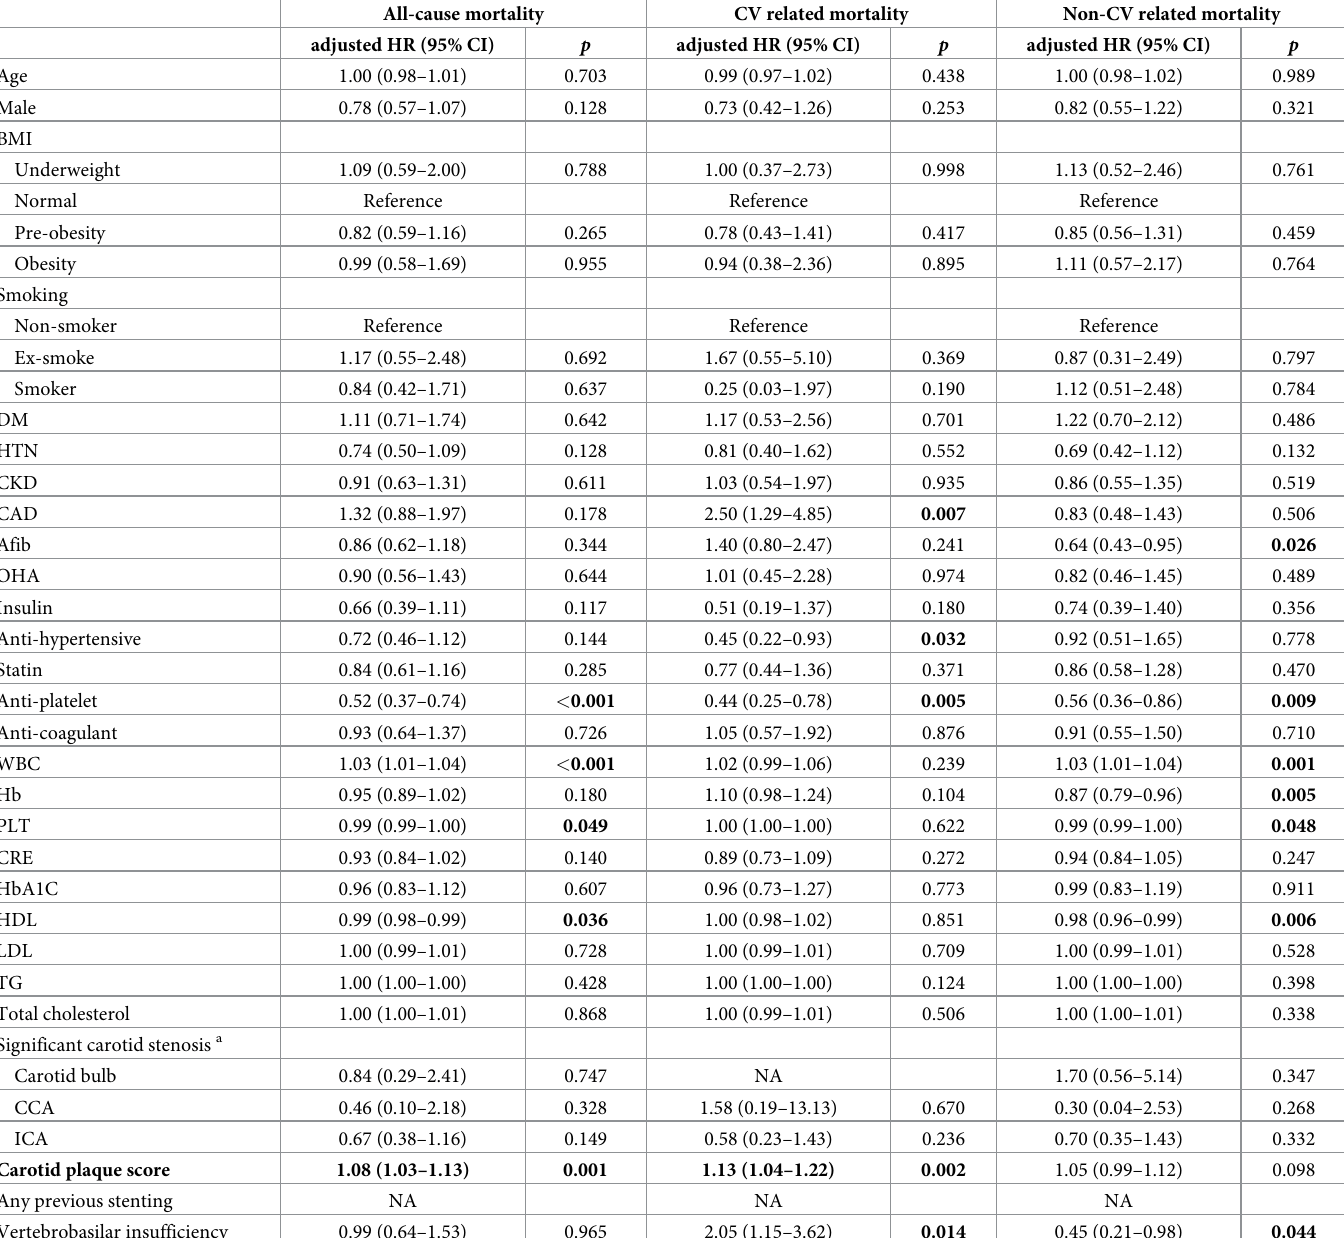
Table 2. Cox regression of mortality within 1–year follow